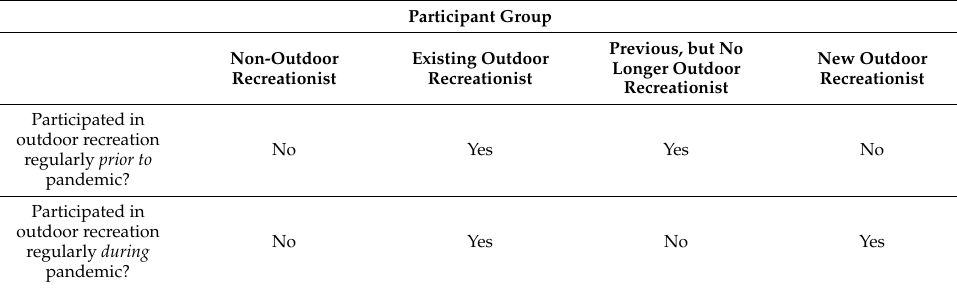
Table 1. Example of screening questions and subsequent